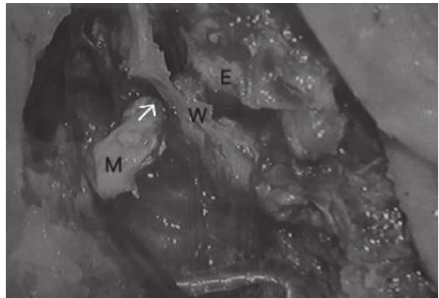
Figure 4: The right external ear canal and mastoid cavity separated by the bony posterior canal wall W is shown with the explanted electrode array in situ. Cholesteatoma diseased tissue which is embedding a part of the explanted electrode array is seen in the middle/external ear E and mastoid M and is connected through the posterior tympanotomy